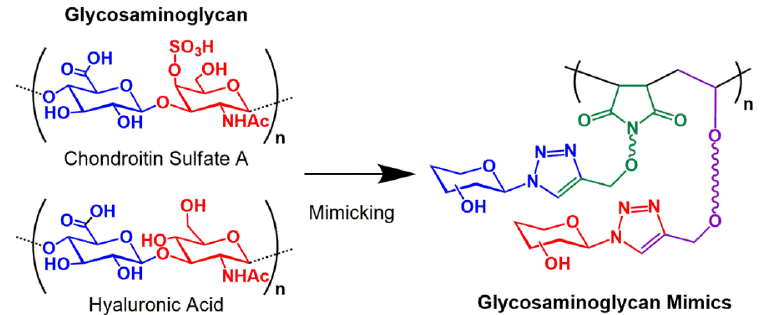
Figure 1. Concept of glycosaminoglycan mimicking in this study.